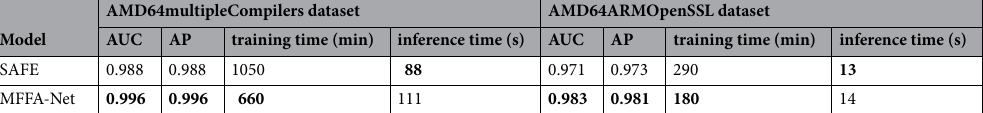
Table 1. Comparison results using different models on two datasets. The inference time is the time consumed in the whole process from the input of the instruction vector sequence to the output of the similarity result in Fig. 2. min minute, s second. Significant values are in